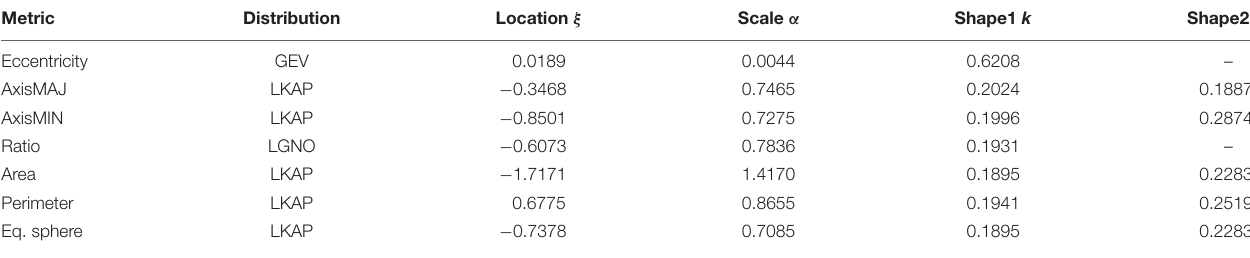
TABLE 2 | Statistical fits summary for unclassified snow grains for the distribution of the log transformed data.